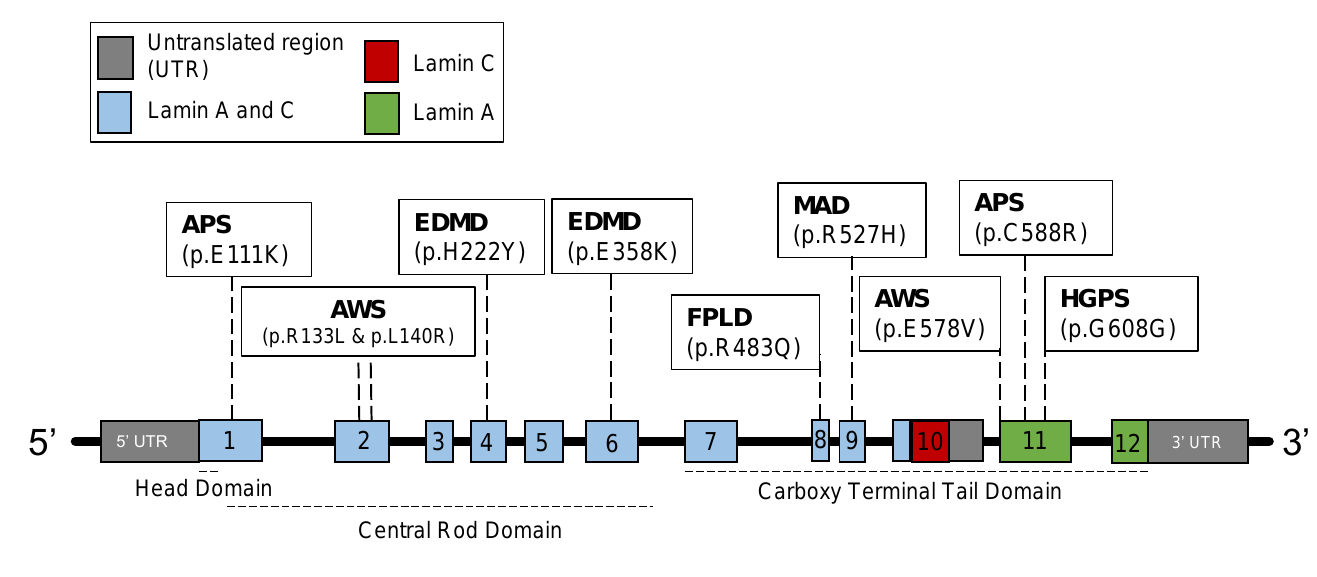
Figure 1. The structure of the human LMNA gene. Lamin C is encoded by exons 1 to 10, while lamin A is encoded by exons 1 to 12. Various mutations identified correlate to pathologies that cause progeroid syndromes and/or segmental diseases affecting connective tissues. EDMD, Emery–Dreifuss mus- cular dystrophy. APS, atypical progeroid syndromes. HGPS, Hutchinson–Gilford progeria syn- drome. AWS, atypical Werner syndrome. FPLD, Dunnigan familial partial lipodystrophy. MAD, mandibuloacral